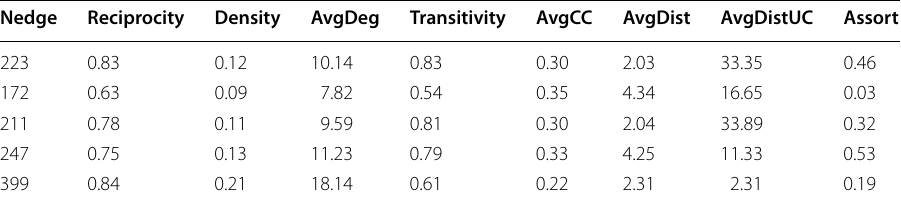
Table 3 Summary statistics for the fall semester ( N = 44 nodes)